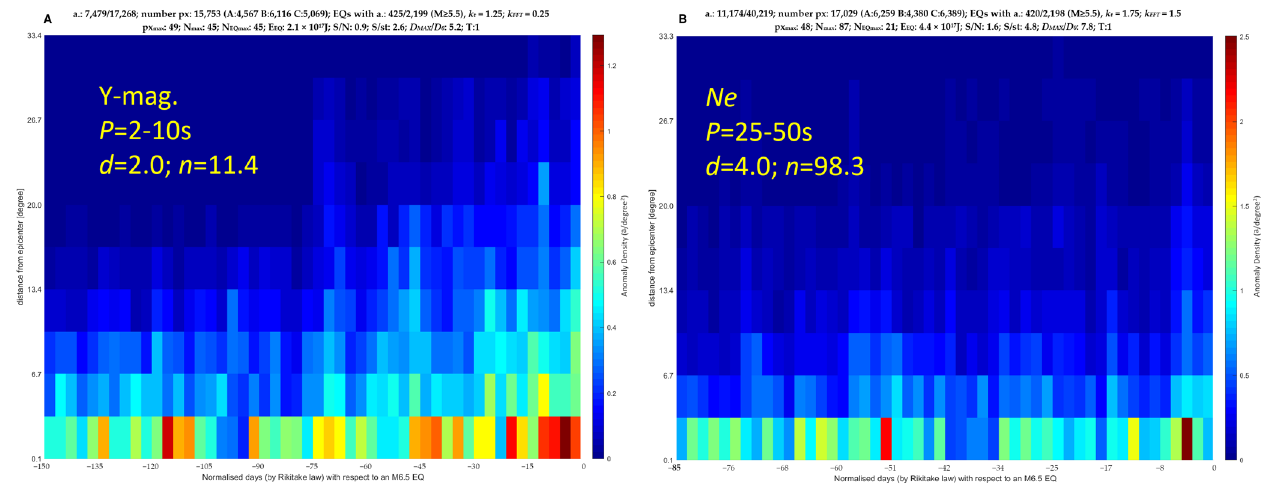
Figure 7. Swarm magnetic field data (Y-mag in ( A )) and electron density ( Ne in ( B )) correlated with M5.5+ earthquakes using modified time according to the empirical Rikitake law.